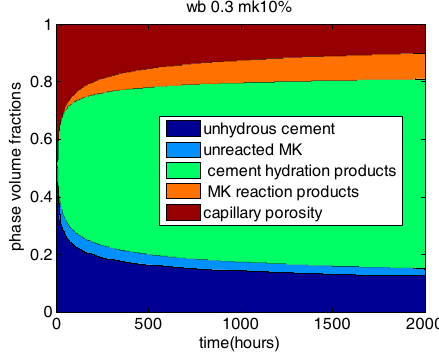
Figure 6. Phase volume fraction of cement-MK paste.